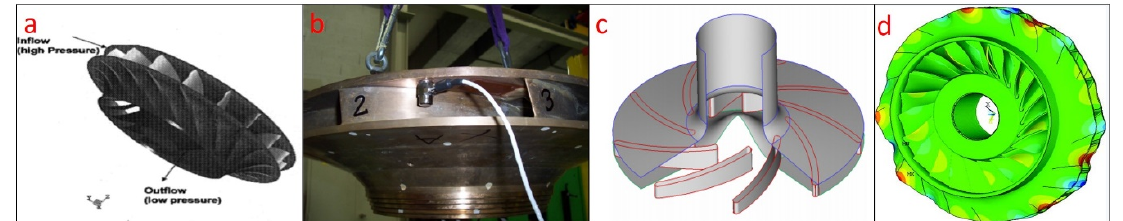
Figure 2. Real engineering cases where disk-blades-disk assemblies are used. ( a ) Low specific speed Francis Turbine runner [39], ( b ) Pump-turbine impeller [40], ( c ) Centrifugal pump impeller [41], ( d ) Centrifugal compressor impeller [42].